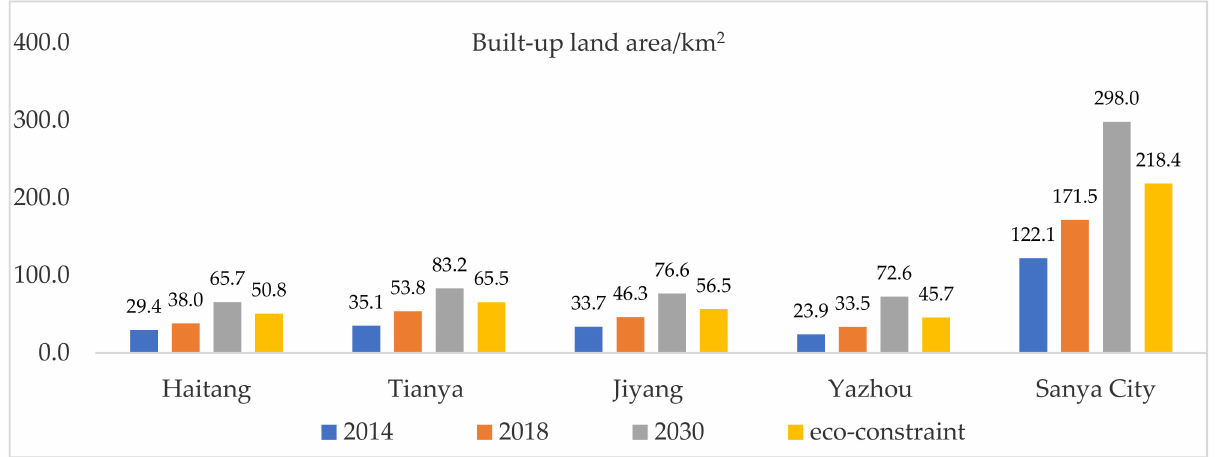
Figure 5. Built-up land area in different